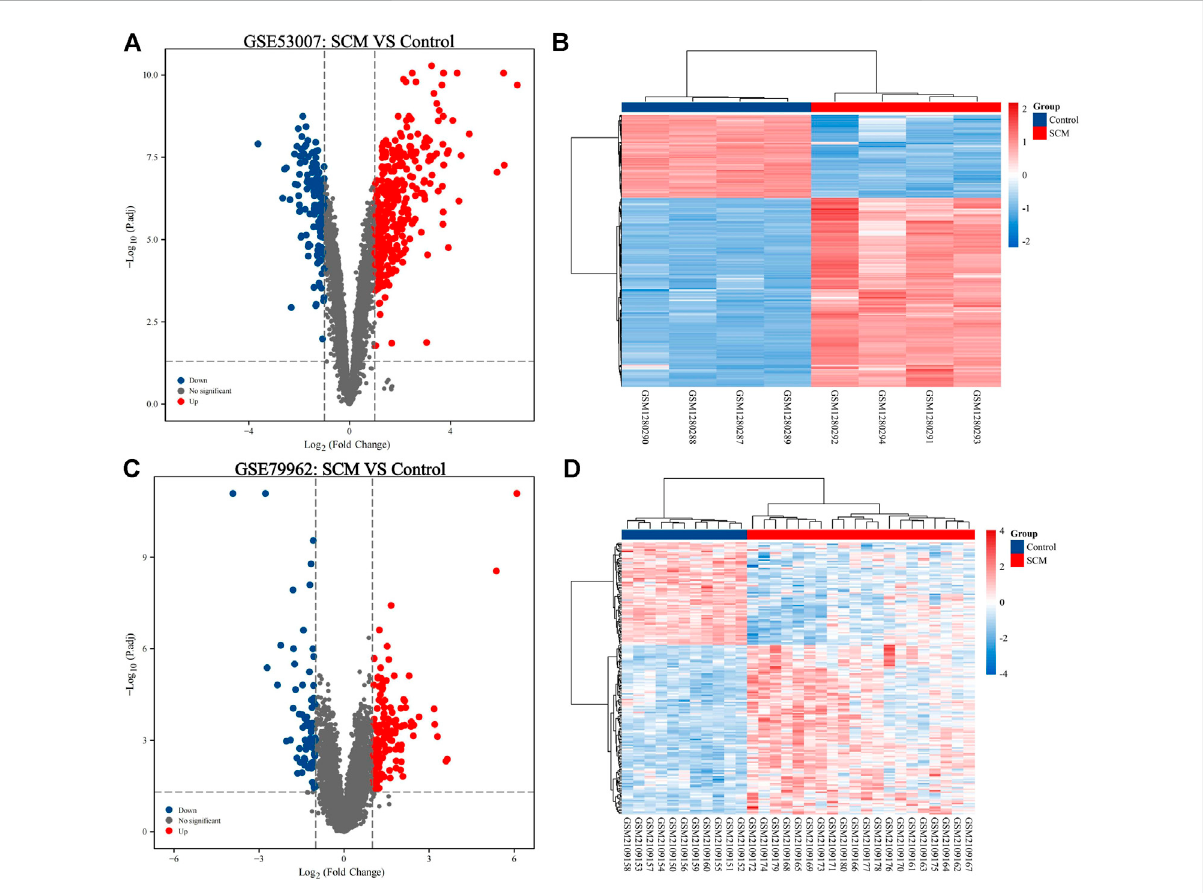
FIGURE 1 Analysis of DEGs. (A) Volcano map of DEGs based on GSE53007 (|logFC| > 1, p. adj < 0.05). (B) Heatmap of DEGs for GSE53007. (C) Volcano map of DEGs based on GSE79962 (|logFC| > 1, p. adj < 0.05). (D) Heatmap of DEGs for GSE79962.